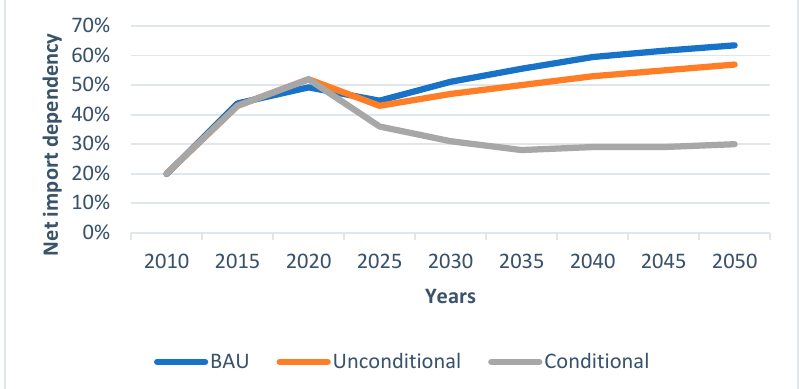
Figure 8. Tunisia’s net import dependency in different scenarios until 2050 (in %). Source: MENA- EDS Model (Scenario: BAU, Conditional, Unconditional).